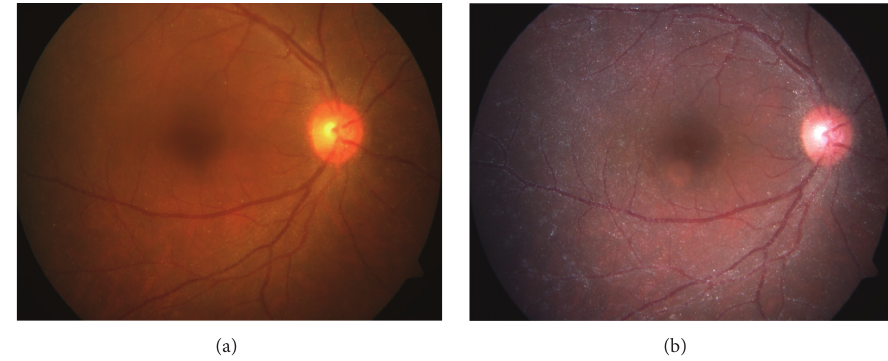
Figure 4: Fundus photograph post cataract surgery showing an apparent increase in crystal deposition ((a) preoperative picture for comparison).